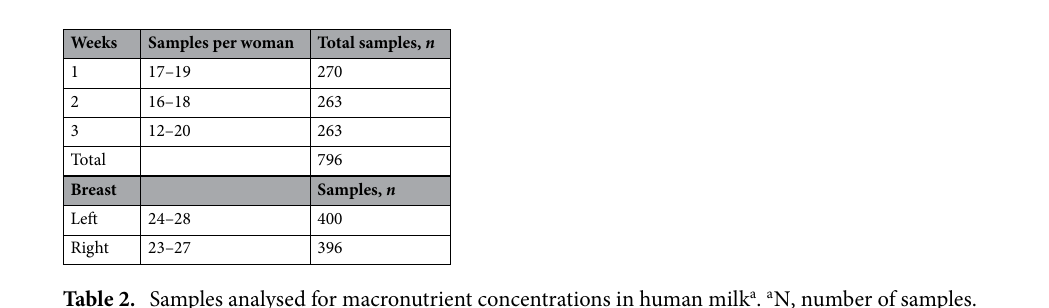
Table 2. Samples analysed for macronutrient concentrations in human milk a . a N, number of samples.